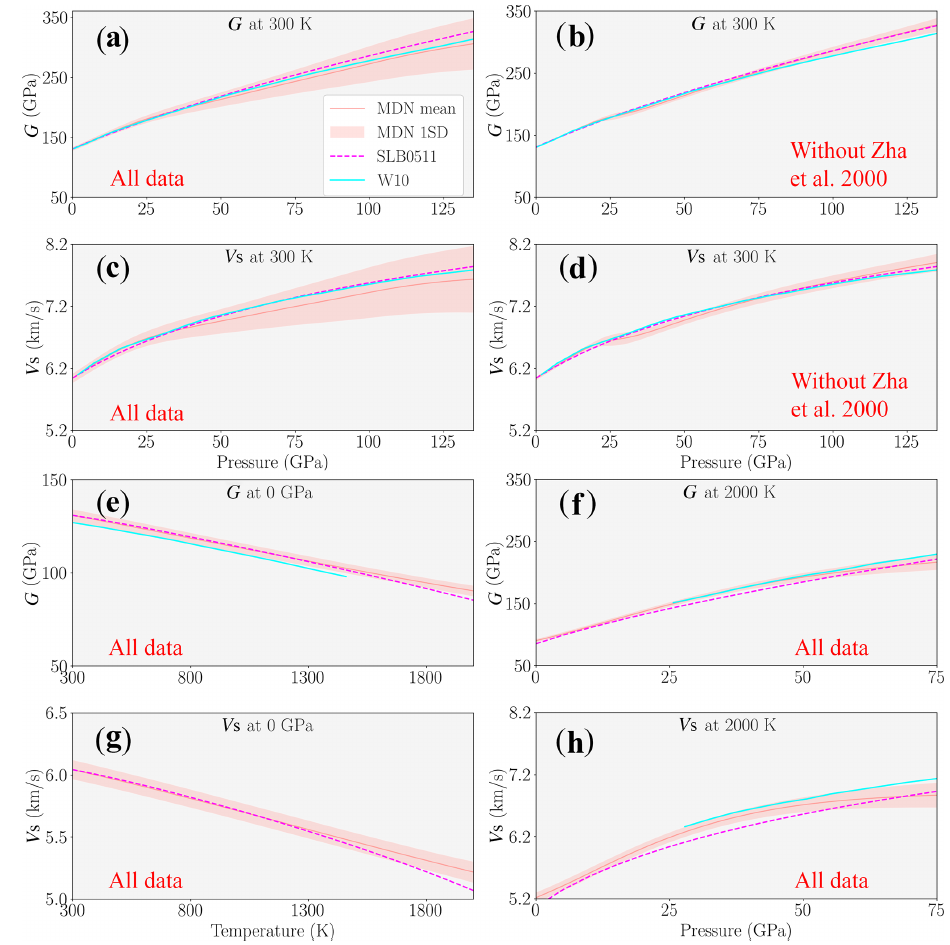
Figure 5. Mean and standard deviation (1SD) of the shear modulus and wave speeds of MgO along 300 and 2000K isotherms and a 0GPa isobar. Only (b) and (d) are from the MDN trained without Zha et al. (2000). W10 data are shown only up to the limit where quasiharmonic approximation is valid (Wentzcovitch et al., 2010a). At 300K, the uncertainties at high pressures are entirely due to Murakami et al. (2009) when excluding Zha et al. (2000). The sudden change in the velocity curvature near 25GPa is due to inconsistency between data from Murakami et al. (2009) and other